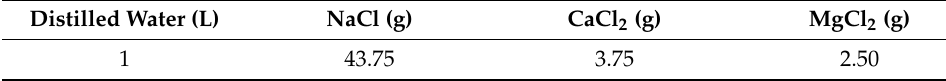
Table 3. Components of the compound formation water.